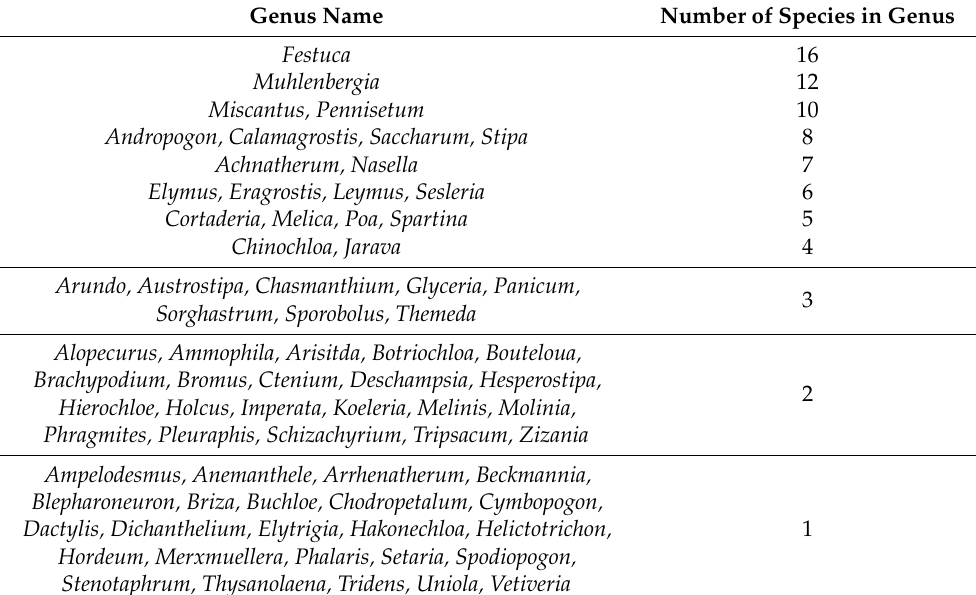
Table 3. Ornamental grasses with genus listed according to their species abundance (according to Table